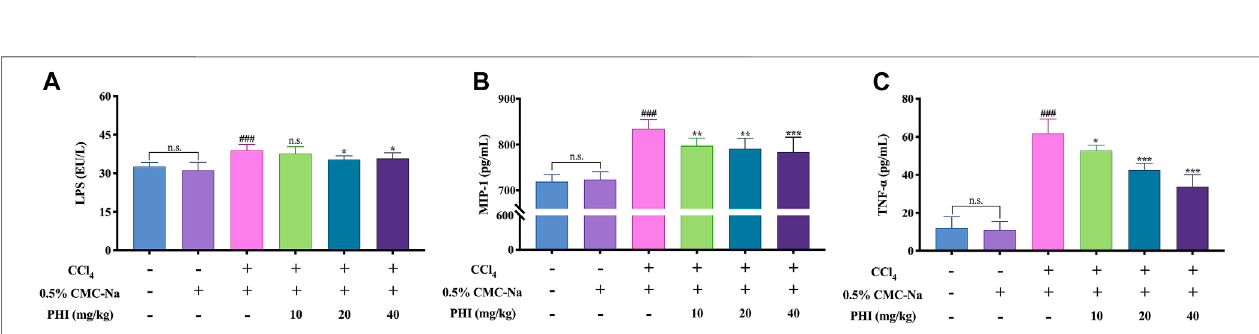
FIGURE 5 | PHI inhibits in fl ammation. (A) Serum LPS level. (B) Serum MIP-1 level. (C) Serum TNF- α level. Data was expressed as the mean ± SD ( n (cid:1) 6). ### p < 0.001 represent compared with solvent control group. * p < 0.05, ** p < 0.01, *** p < 0.001 represent compared with CCl 4 group. n. s indicates no signi fi cant.